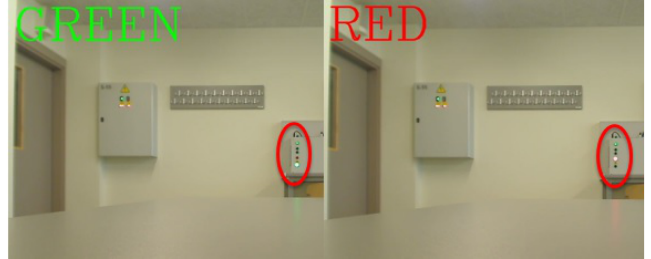
Fig. 13. Traffic light signal recognition experiment.